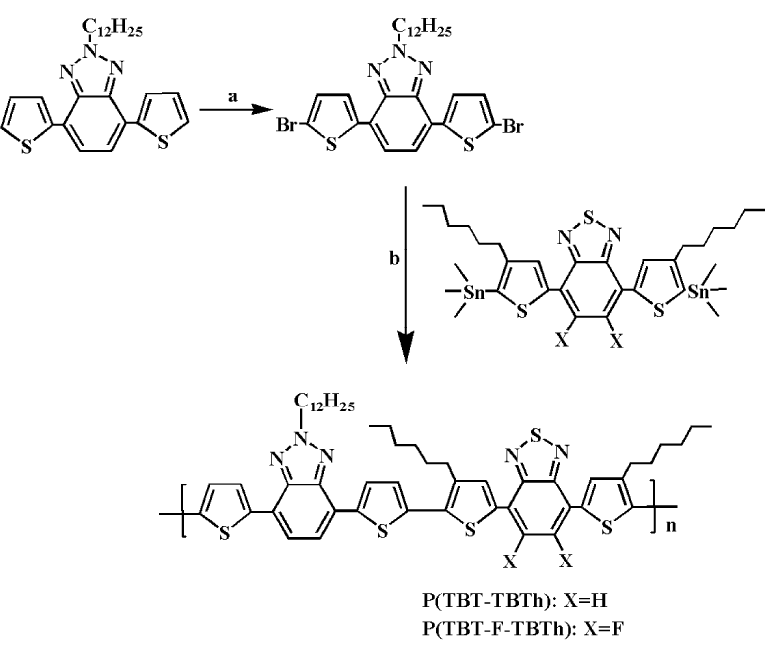
Scheme 1. Graphical representation of reaction process of the polymers: ( a ) N-bromosuccinimide (NBS), dichloromethane (DCM)/glacial acetic acid (HAC), refluxed, 12 h; ( b ) Pd(PPh 3 ) 2 Cl 2 , toluene,